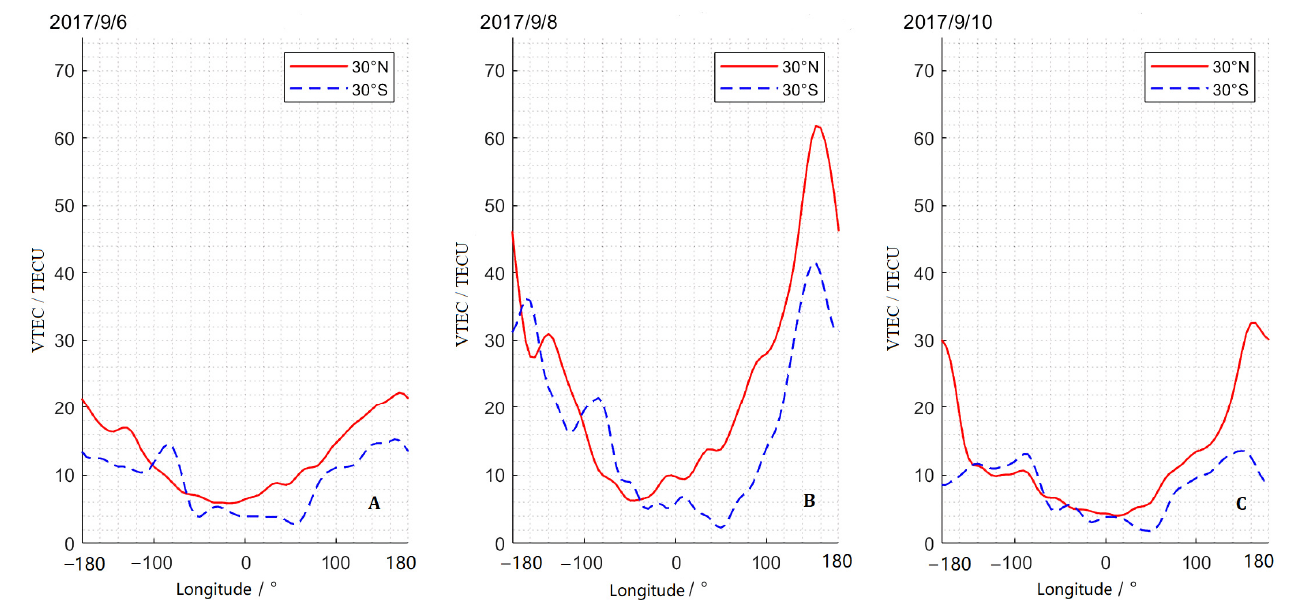
Figure 7. Fluctuation characteristics of VTEC on 30° N/S latitudes at UTC 2:00. The blue dotted line and the red solid line represent the southern and northern hemisphere VTEC, respectively, unit: TECU. Panels ( A – C ) show the VTEC characteristics of the pre-, mid- and post-geomagnetic storm phases, respectively.